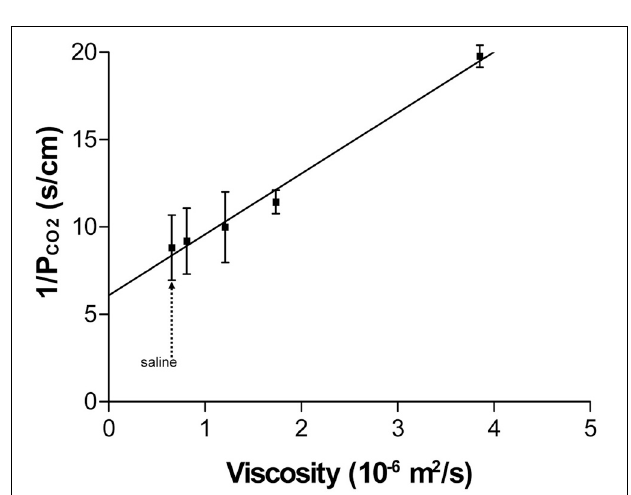
FIGURE 15 | Plot of the reciprocal of the experimentally determined ( P CO ) vs. the kinematic viscosity of the dextran red cell P CO 2 2 , app solution in which it was measured. Extrapolation of the linear relation to ( P CO ). 37 ◦ C. “Saline” zero viscosity yields the true membrane P CO 2 2 , true measured in the absence of dextran. Reproduced from indicates the P CO 2 Endeward and Gros (2009), with permission.